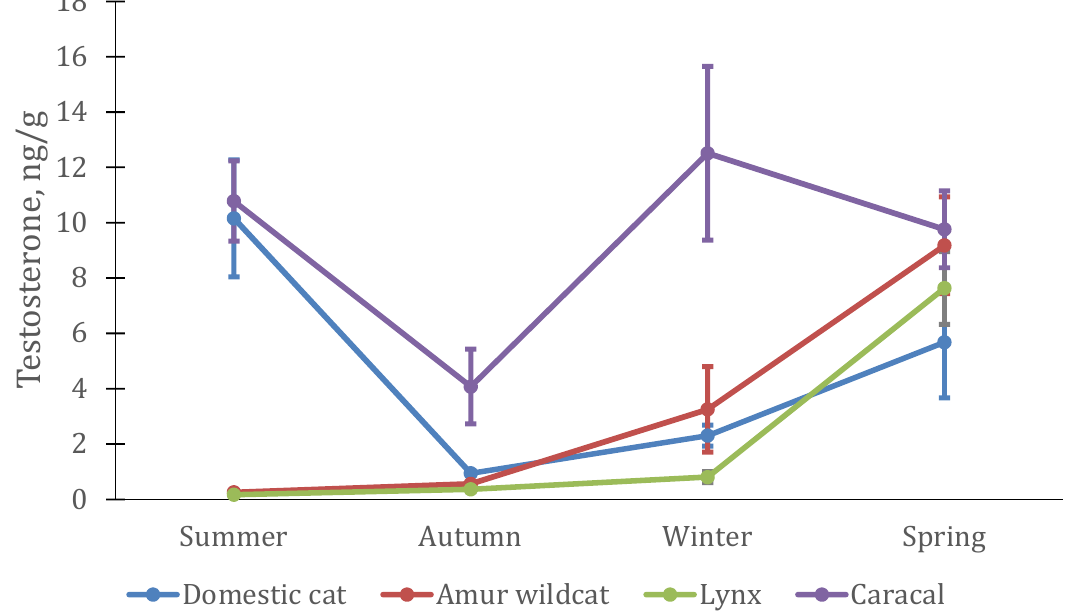
Figure 3. Testosterone concentration in hair from four male felid species ( n = 5 domestic cats, n = 4 lynx, n = 4 Amur wildcats, n = 4 caracals).